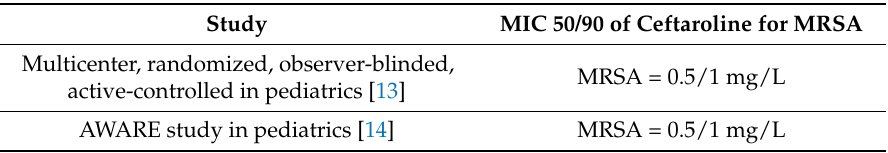
Table 1. MIC 50/90 of ceftaroline for MRSA in pediatric